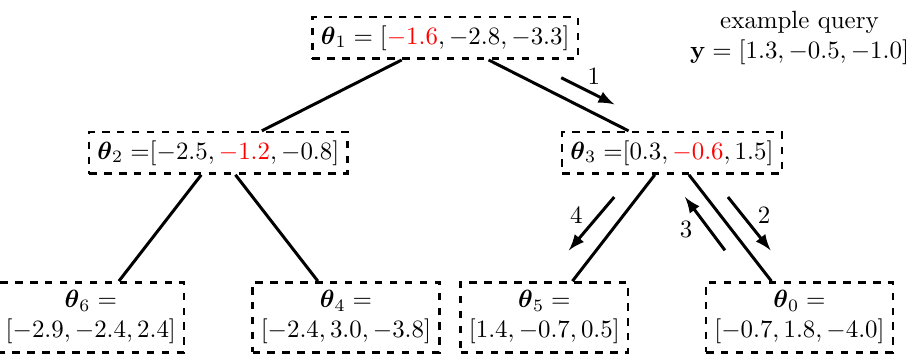
= 7 length N = 3 random vectors θ 0 , θ 1 , . . . , θ 6 . Figure 4. Exemplary K -dimensional tree with |T | The vectors are arranged according to decision thresholds given by the axis coordinate highlighted in red in the subsequent levels of the tree. Arrows indicate the processing of querying the nearest neighbor of the vector y